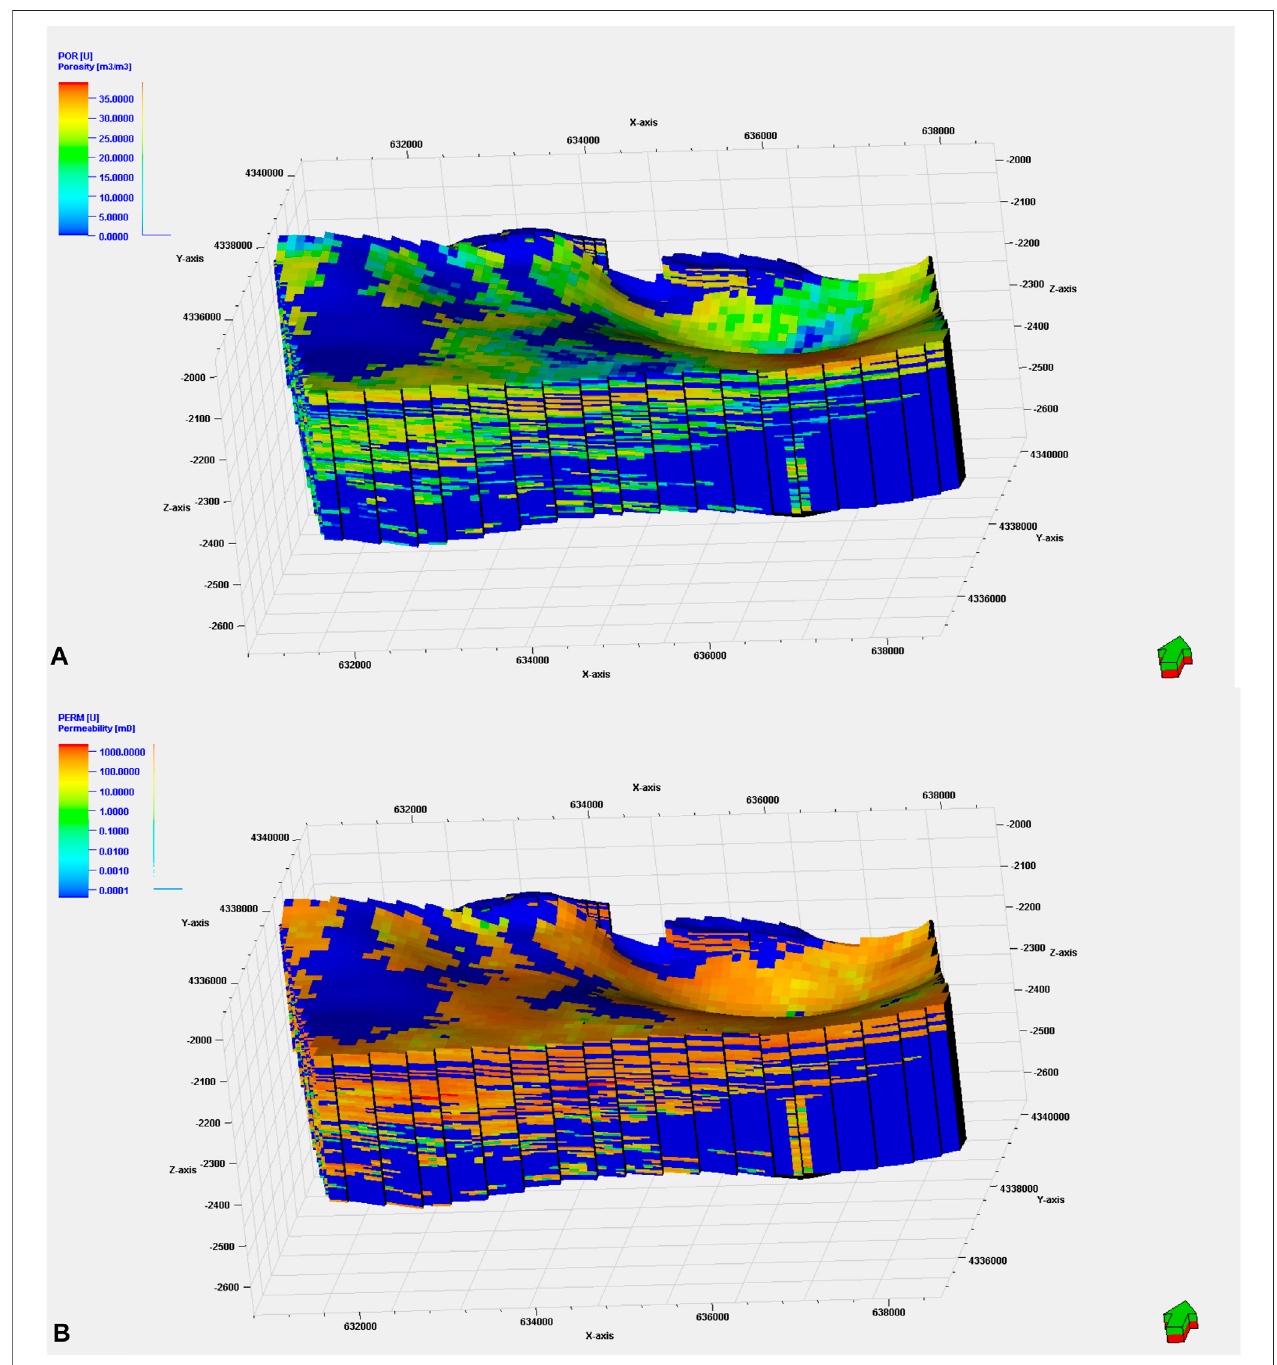
Frontiers in Earth Science |